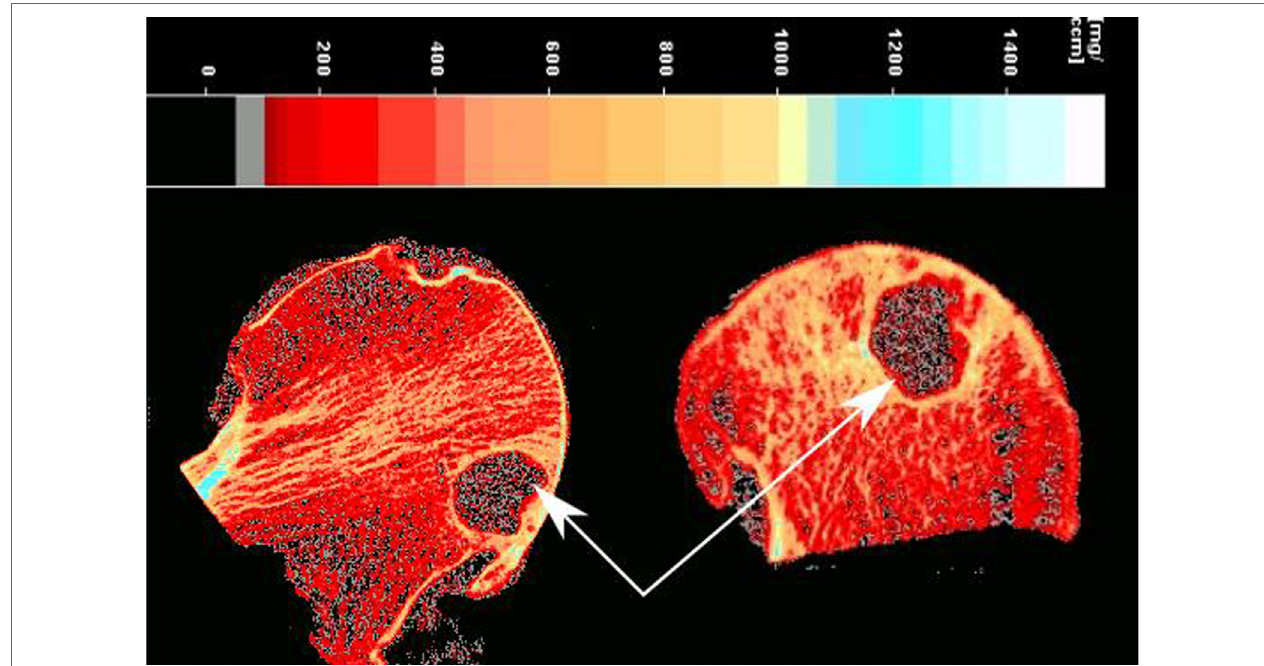
FigUre 2 | Presence of a large cyst (white arrows) in an osteoarthritis